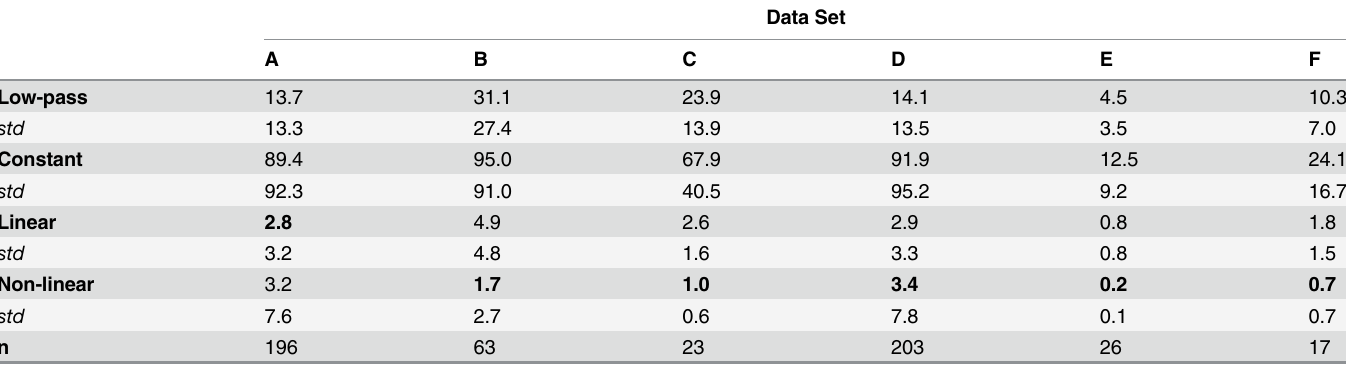
Table 2. MSE for the different analysis methods.